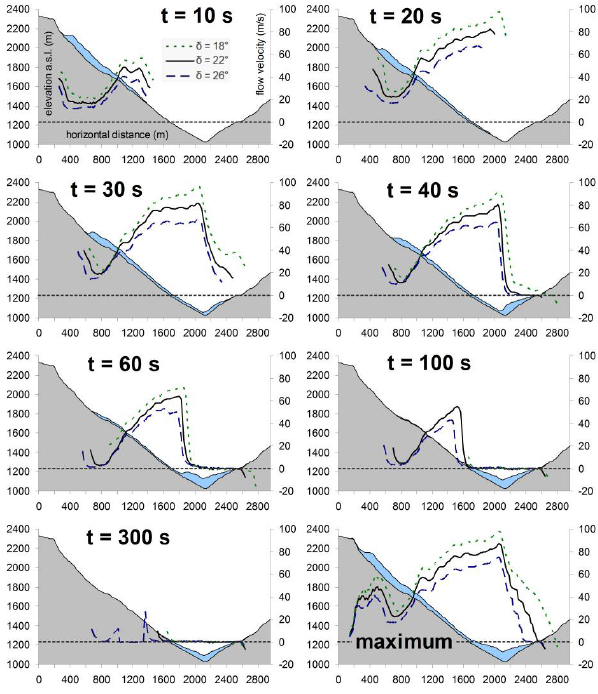
Fig. 11: Velocity profiles along the assumed talweg with different assumptions of δ for selected time steps and for the maximum over the entire flow. The values are positive in downslope direction (from left to right).